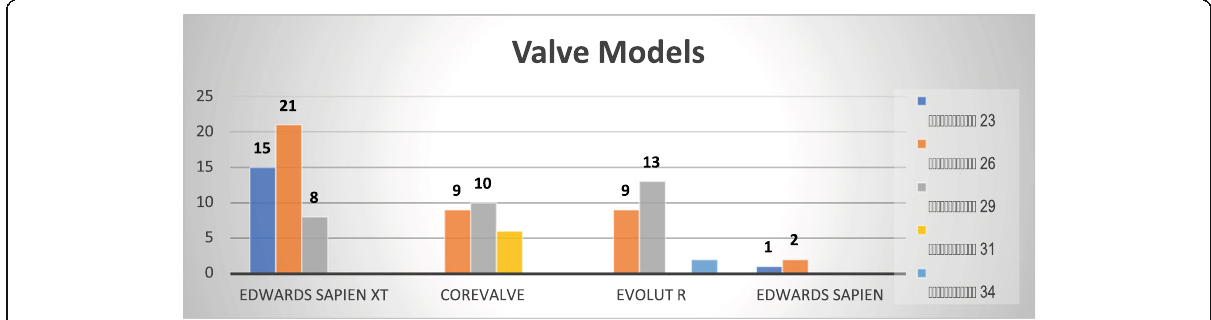
Fig. 3 Different valves used in the study. The colors in the legend represent the sizes of the valves provided by manufacturer